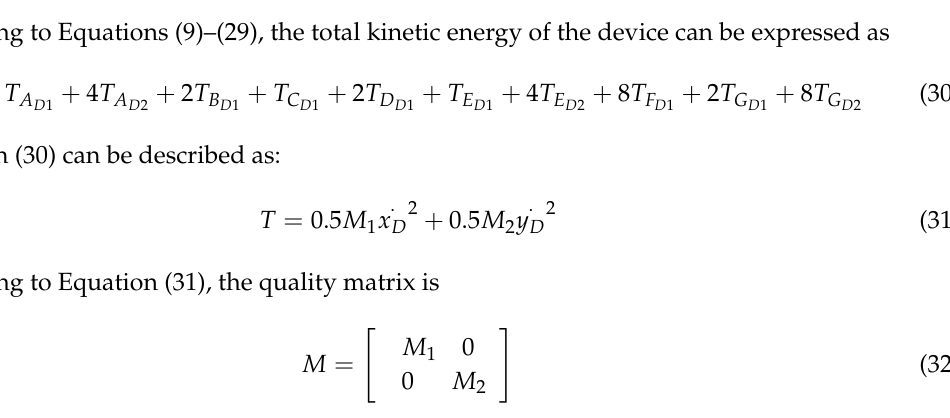
Figure 21. Unit 𝐺 (cid:3005) structure. Figure 21. Unit G D